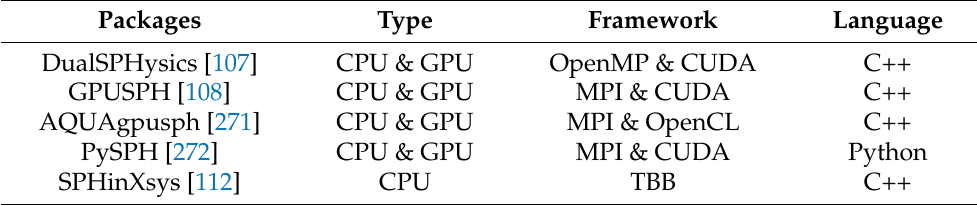
Table 3. The parallelization framework for different open-source